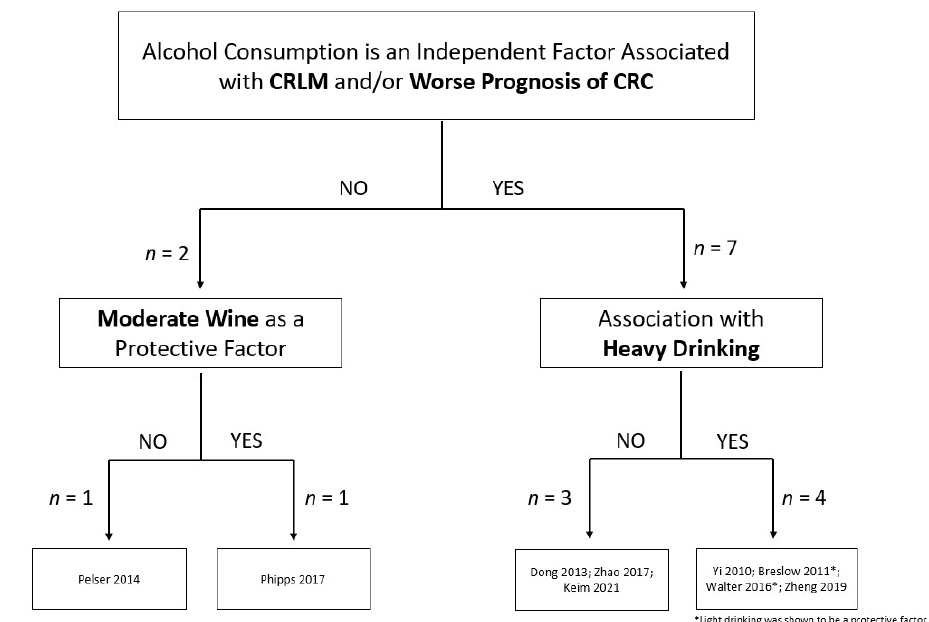
Figure 5 . Summary of clinical reports investigating the association of alcohol and colorectal cancer outcomes [9,12,13,16,18–22].